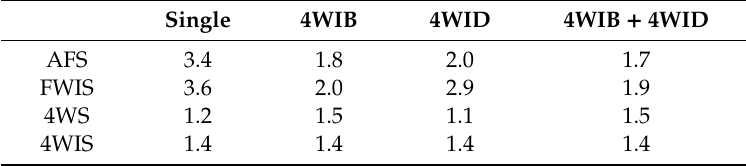
Table 3. Maximum absolute side-slip angles for each actuator combination (deg.).